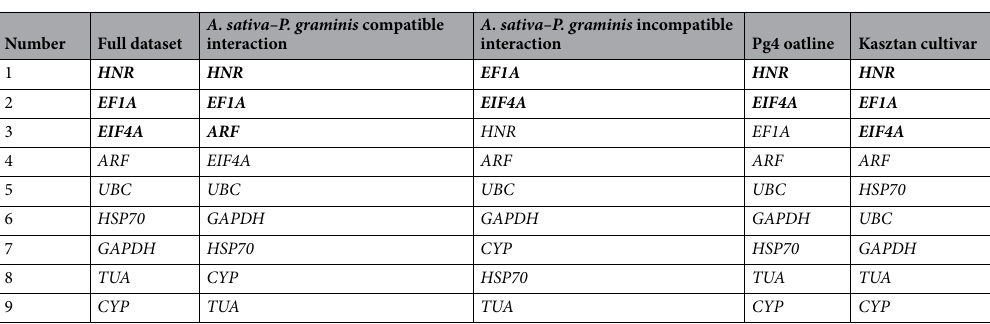
Table 3. Comprehensive rankings generated for analysed datasets based on the results obtained with four algorithms. Reference genes recommended for RT-q PCR data normalization are shown in bold.